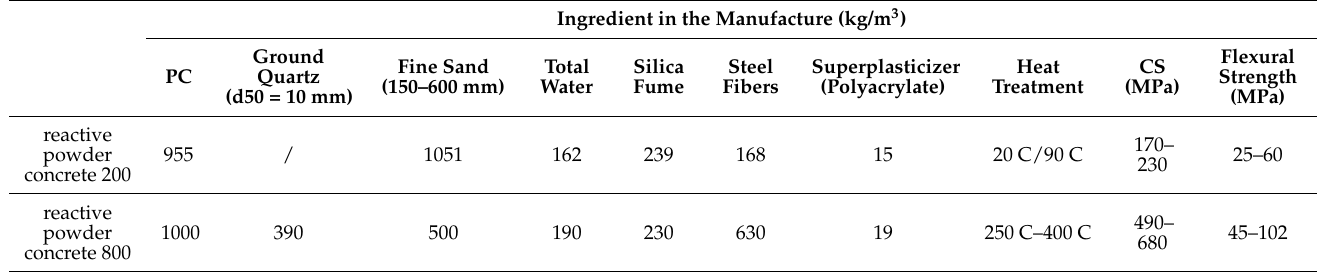
Table 1. Typical mechanical parameters and reactive powder concrete composition of UHPC were provided by Richard and Cheyrezy